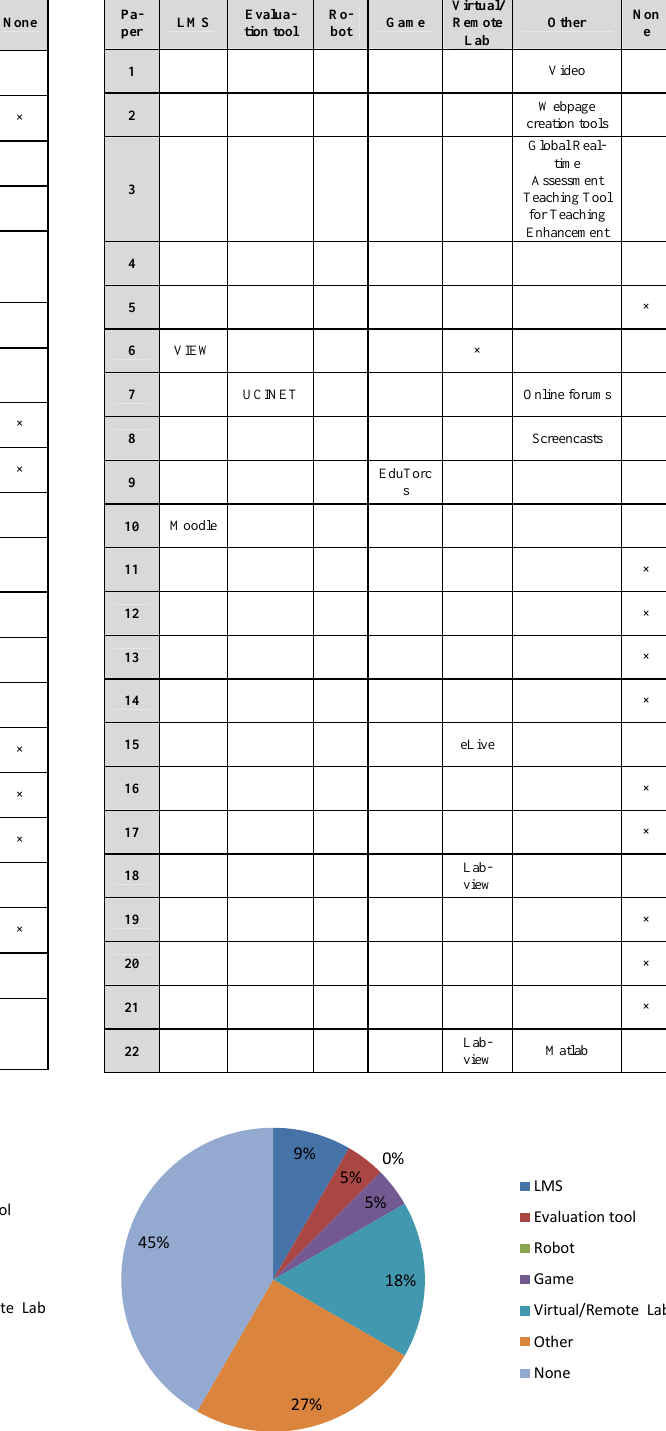
TABLE III. T ECHNOLOGY T OOL D IMENSION , IEEE T RANSACTIONS V OL . 54, N1